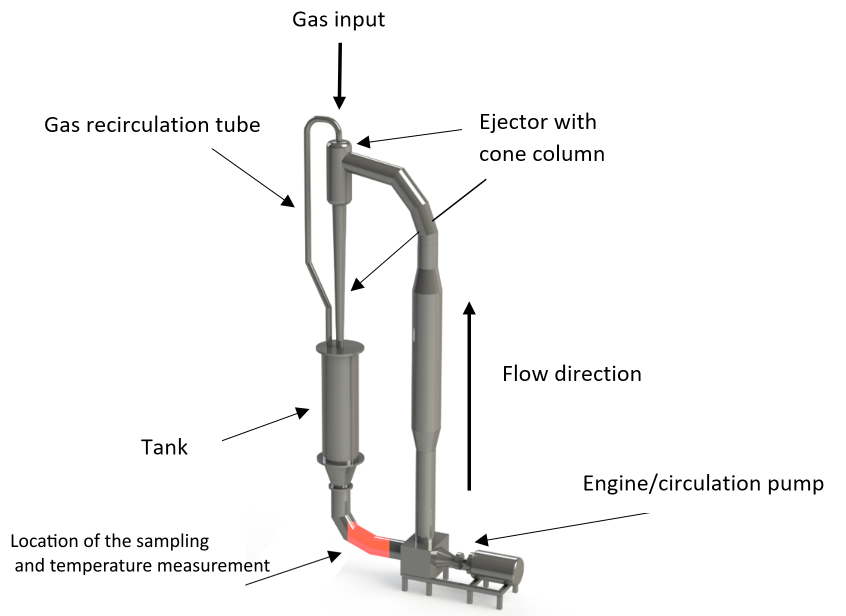
Figure 1. Experimental setup for measuring the mass transfer of the air–liquid flow. The design of the experimental setup corresponds to the real field jet bioreactor for manufacturing the microbiological single-cell protein and corresponding high-added-value